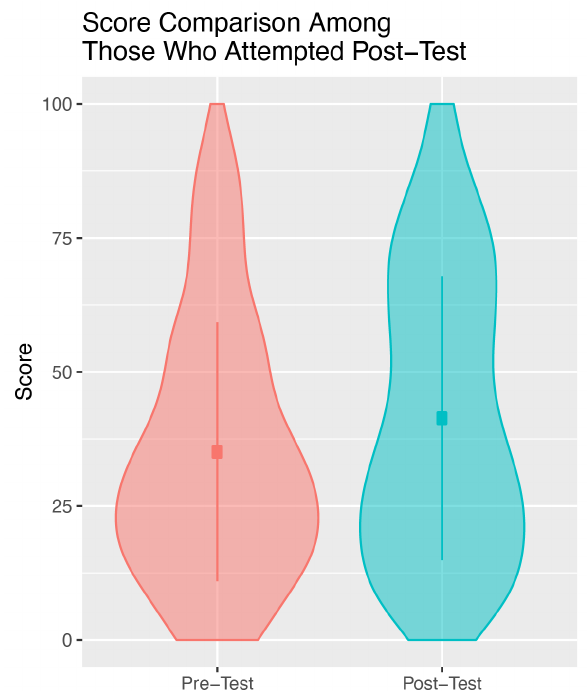
Figure 9. Violin plot of score distributions in the pre- and post-test, for those students who completed both tests (N=246). Points represent means, and bars represent two times the standard error.